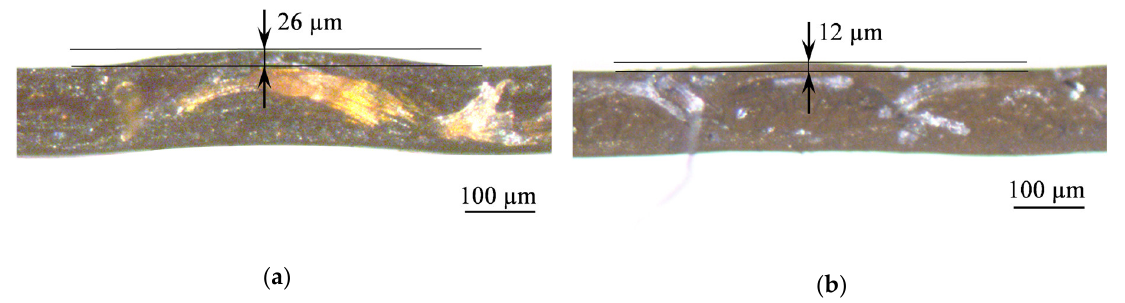
Figure 4. Optical images of cross sections of dry membranes AMX-Sb ( a ) and AMX ( b ). The black arrows show the distance between the black lines indicating the height of the undulation.